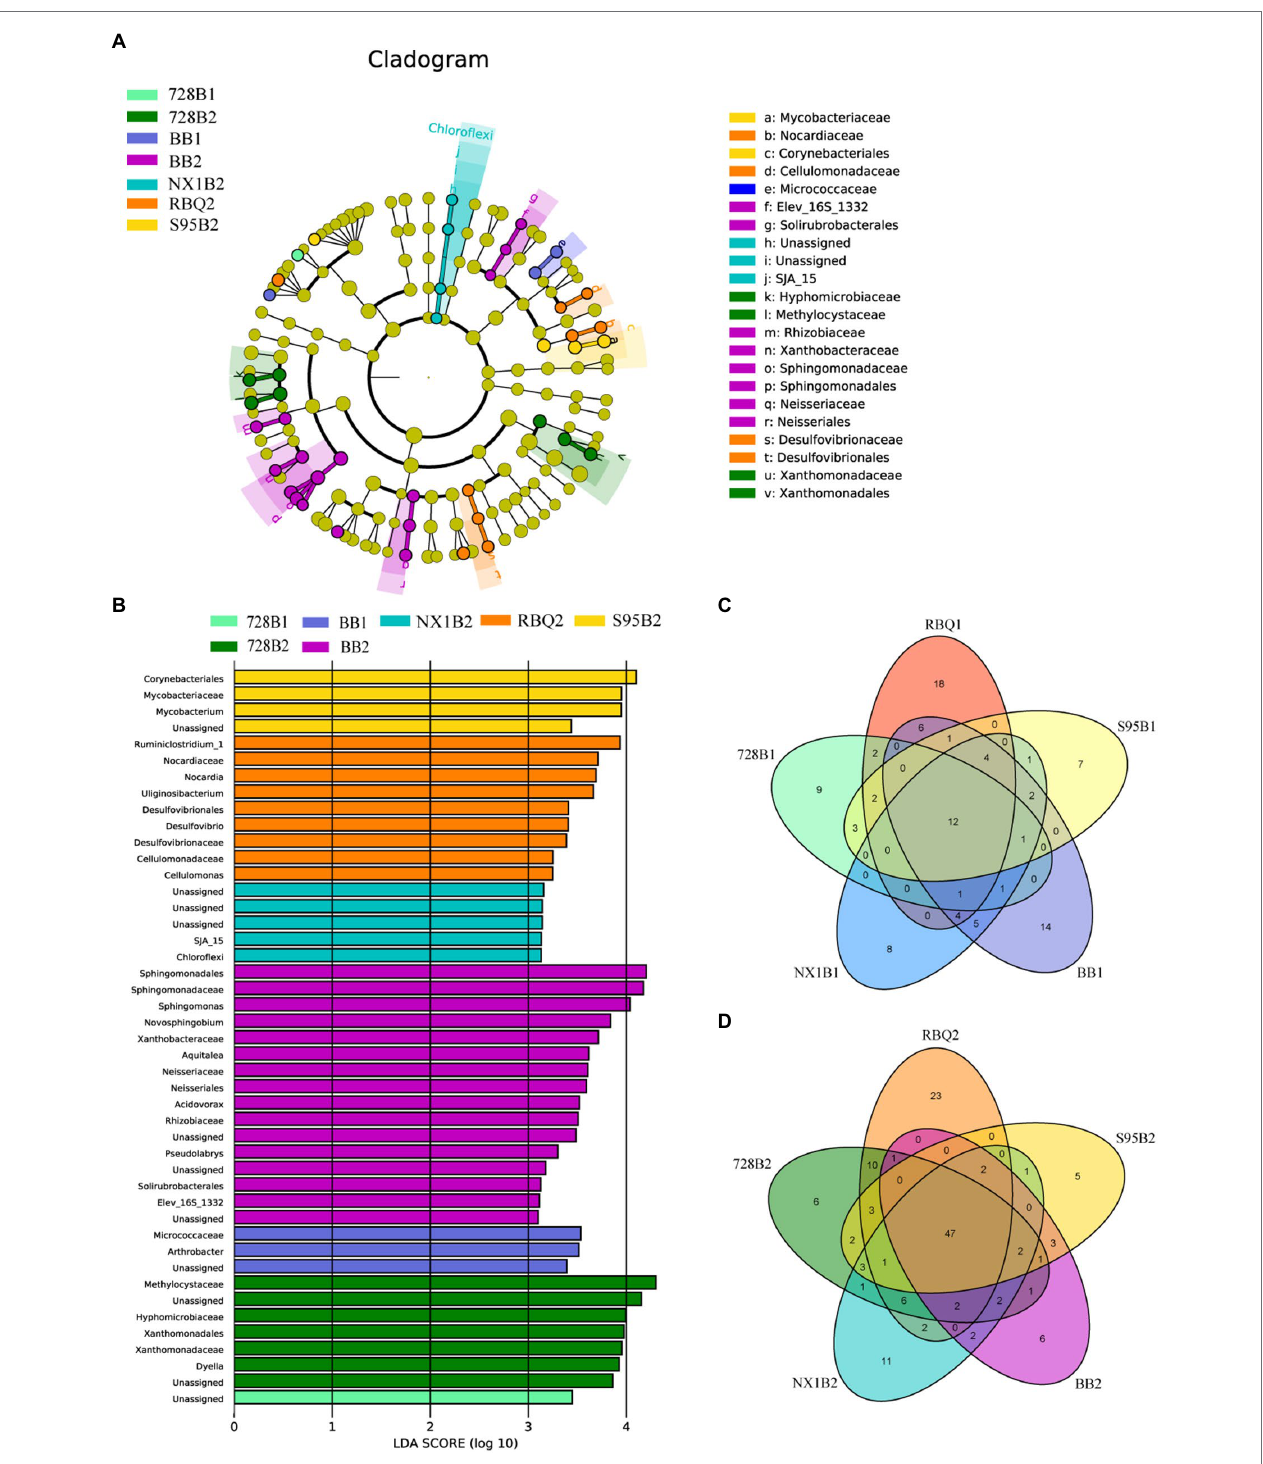
FIGURE 4 | (A–B) Taxonomic cladograms of linear discriminant analysis effect size (LEfSe) analysis of rice cultivars at two developmental stages, depicting OTUs with absolute linear discriminant analysis (LDA) scores larger than 3. Venn diagrams show shared and specific OTUs among five rice cultivars at the vegetative (C) and reproductive (D)